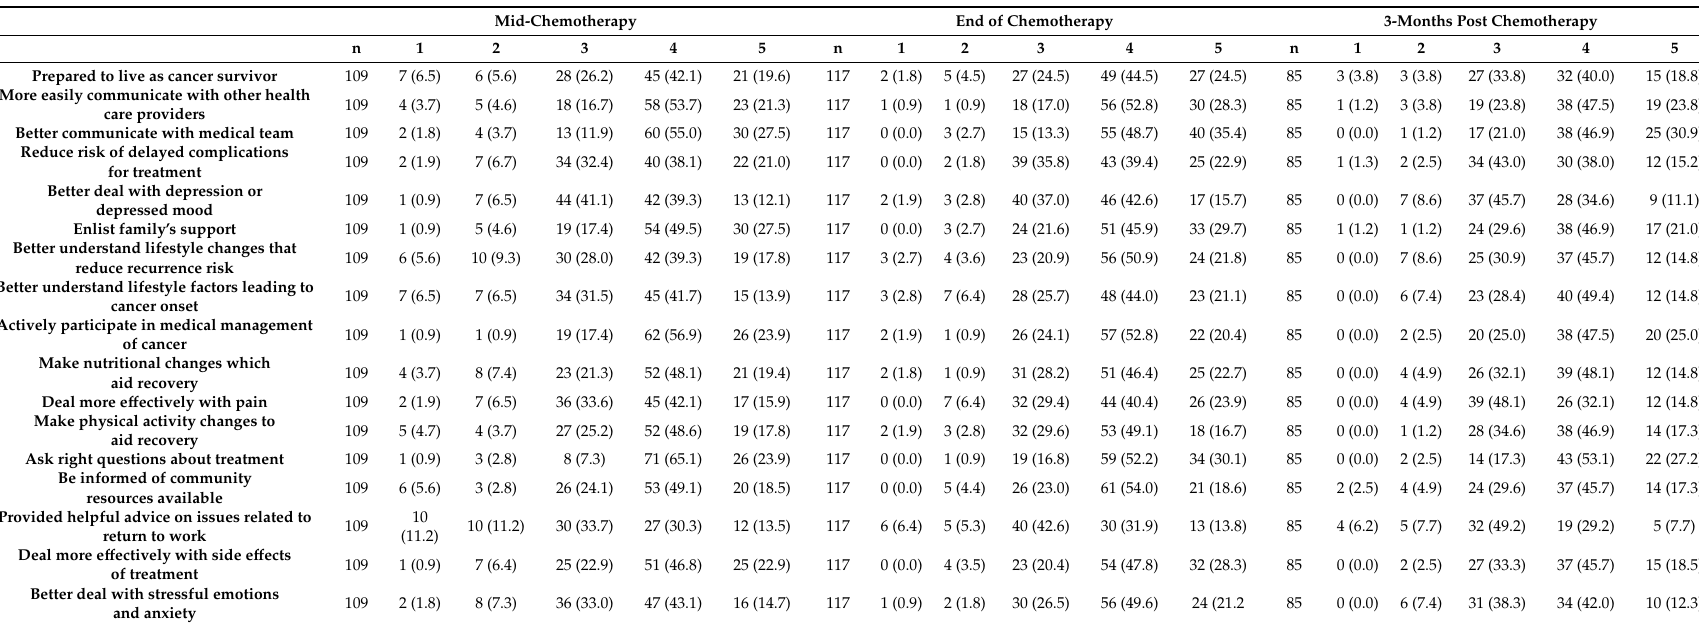
Table A1. Responses reported by patients regarding satisfaction with the personalized treatment and care